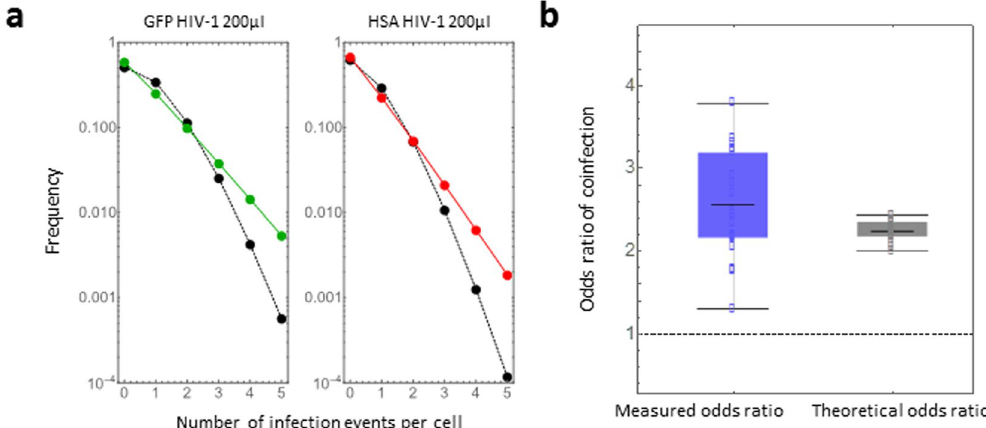
Figure 3. Frequency of multiple infection events per cell: ( a ) The expected negative-binomial distributions of the number of infection events per cell in 200 μ l in GFP and HSA HIV-1 single experiments are shown in green and red curves, respectively. These curves were drawn using the mean derived from MCMC parameter inferences (Table 1). The black curves represent the expected Poisson distribution with the mean of the Gamma- distributed susceptibility parameter, s (i.e., the target cell population is assumed to have homogeneous susceptibility). (b) The experimental odds ratio ( OR ) and theoretical odds ratio ( OR , calculated by our E M estimated parameters) are shown in blue and black box plots, respectively. The dotted line corresponds to the odds ratio of 1 predicted by a Poisson distribution